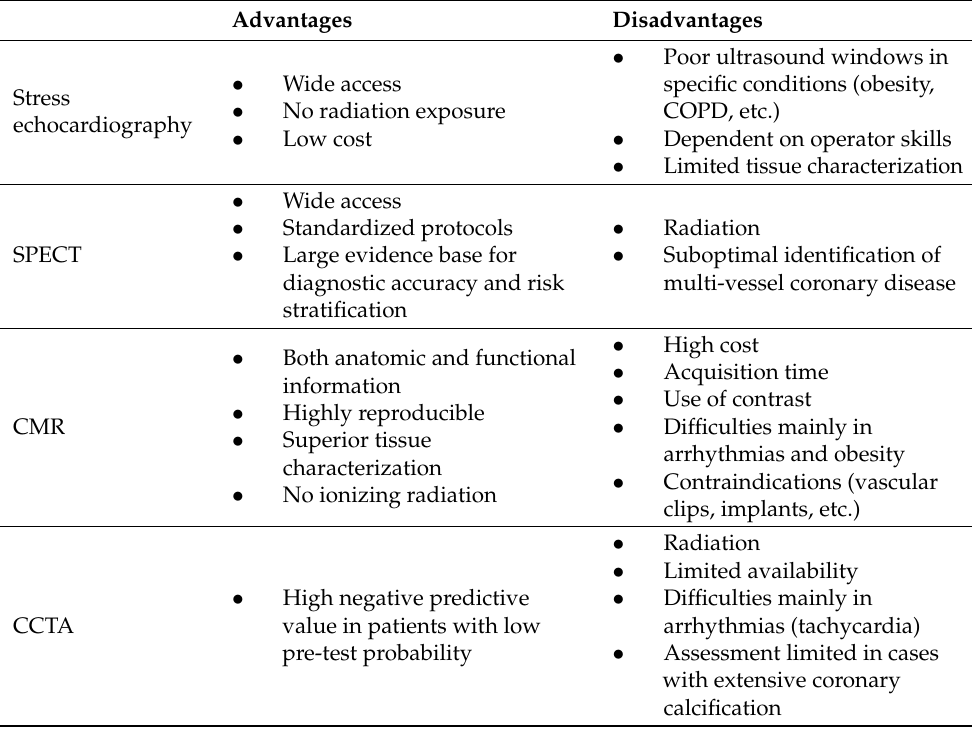
Table 1. Advantages and disadvantages of the commonly used imaging modalities in the manage- ment of coronary artery disease